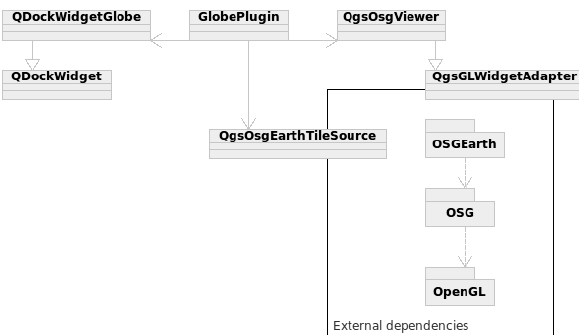
Figure 1. Globe Plug-in dependencies and high level